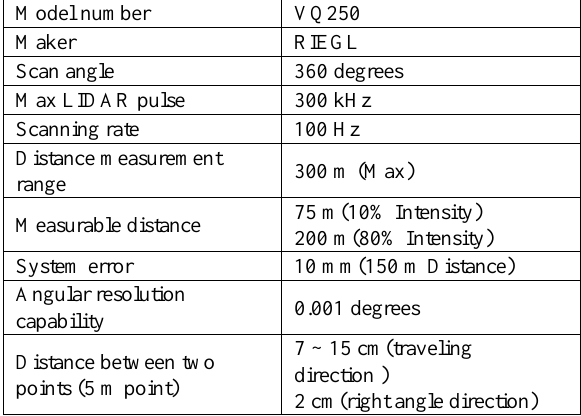
Table 1. Specification of the LIDAR scanner